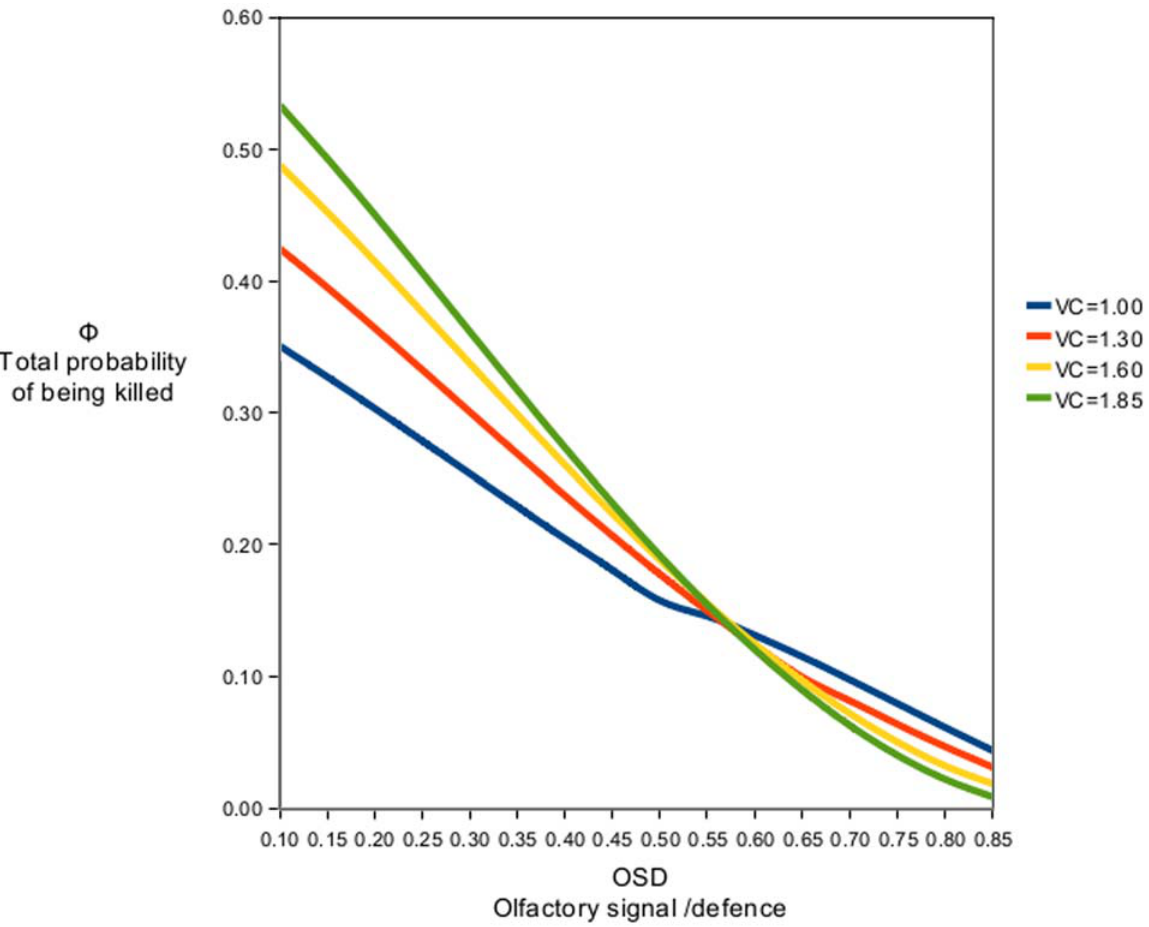
Figure 1. Visual and olfactory components and total probability of being killed. Different fixed values for VC (visual conspicuousness) are plotted against OSD (olfactory signal and defence) values, showing variation in the total probability of being killed ( W ). Selective forces acting on conspicuousness undergo a shift when defence levels reach a critical value (point of intersection). Our model predicts that maximum conspicuousness is the best strategy when the individuals are maximally defended through